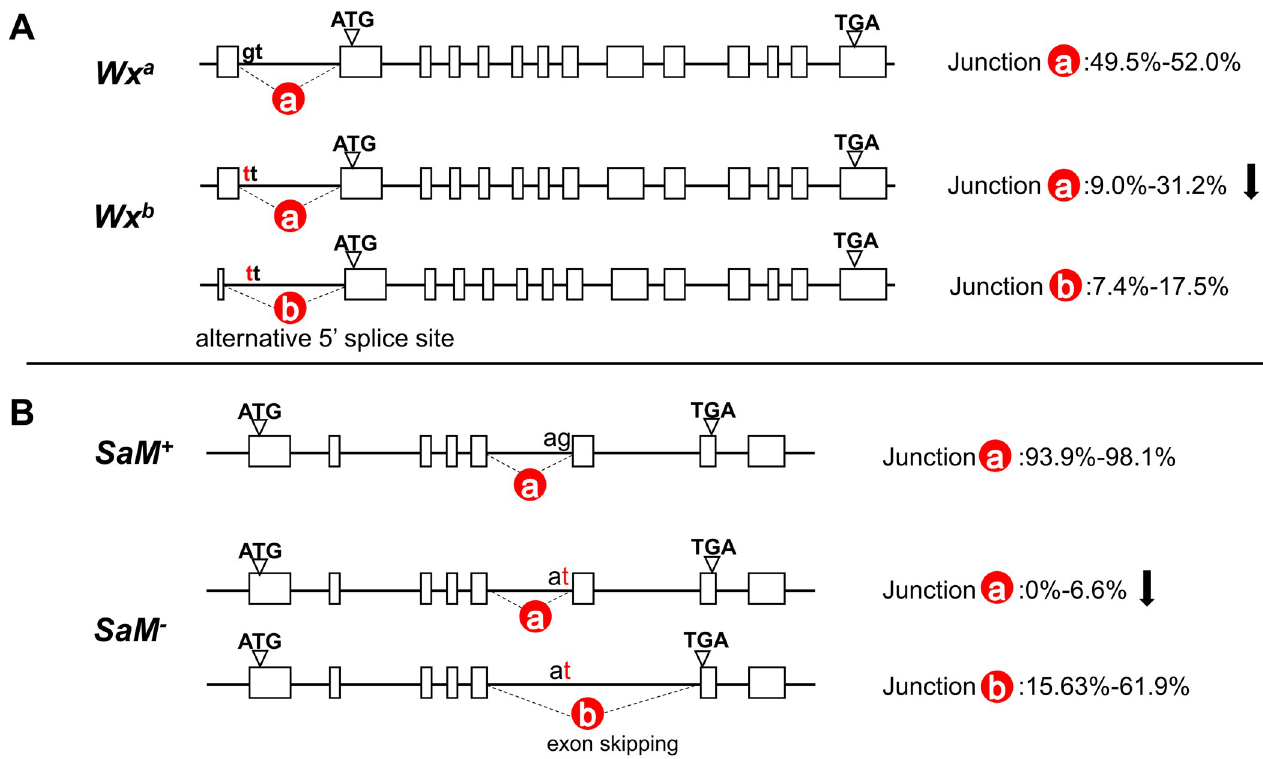
Fig 7. Splicing- mediated rescue in alleles with point mutations in rice. RNA-seq data were collected from 55 downloaded datasets and 2 local sequenced O. rufipogon samples (SRR14163371, SRR14163372). The RNA-seq data were processed with the same pipeline described in the paper to obtain the splicing junctions of different (A) Waxy and (B) SaM alleles. The proportions of different splicing junctions were calculated as (junction reads/junction region depth). Dashed lines represent differentially employed junctions. The major splice form in Wx a involves Junction-a with Junction-b not being detected. SaM Junction- b is also not detected in SaM + . In addition to the two splice forms with junction-a and junction-b (the sum of them is not 100%), another major form of splicing is intron 5 retention. The position of each junction: Waxy- Junction-a: chr06:1765760–1766889; Waxy- Junction-b: chr06:1765667–1766889; SaM – Junction-a: chr01:22380909–22381236; SaM –Junction-b: chr01:22380909–22382464.